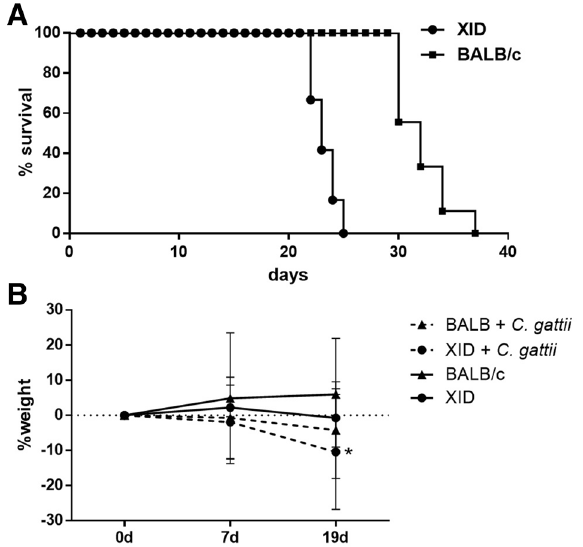
Figure 1. Evaluation of XID and BALB/c susceptibility to C. gattii infection. ( A ) Survival assay of XID (n = 10) and BALB/c (n = 10) mice infected with Cryptococcus gattii strain R265 belonging to serotype IIa. Time in days post-infection is shown on the x-axis. ( B ) The weight variation of the XID (n = 12) and BALB/c (n = 12), (infected or uninfected) mice was monitored during the infectious process, 0, 7 and 19 days of infection were the times stipulated for analysis. The graphs show the results of 2 independent experiments. ( ### p < 0.001) for comparative degree between strains. (*p < 0.05) for comparative degree between days 0 and 19 (0 d × 19